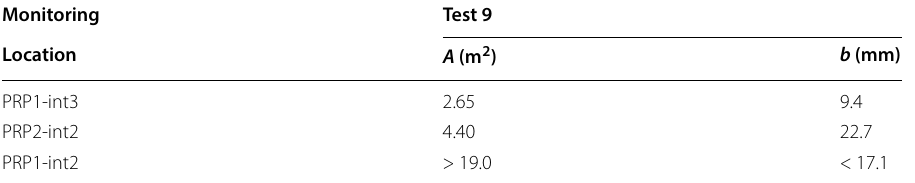
Table 4 Results of solving fracture surface area using Eq.